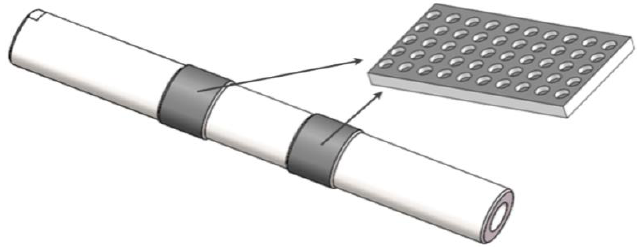
Figure 2. Cylindrical texture geometric model of impact piston surface.